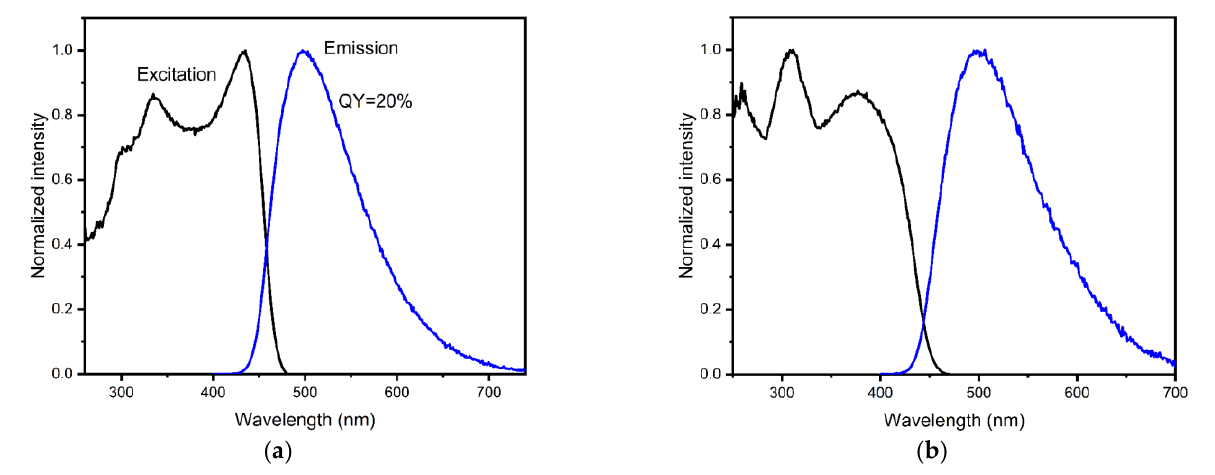
Figure 3. Excitation and emission photoluminescence spectra of MOF 1 : ( a ) in the solid state; ( b ) in ethanol suspension. Table 1. Photoluminescence quantum yields of LMOFs containing 2,1,3-benzothiadiazole